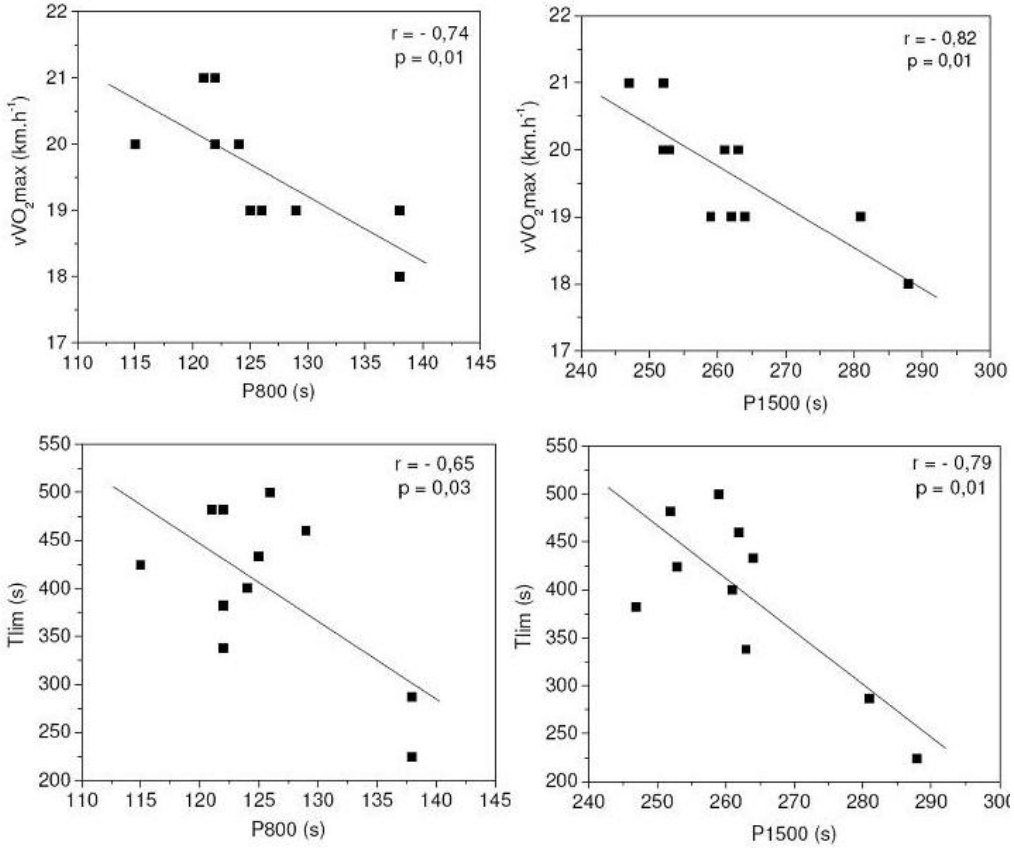
Figura 1 . Correlação da vVO max e do Tlim com as performances nas distâncias de 800 m e 1500 2